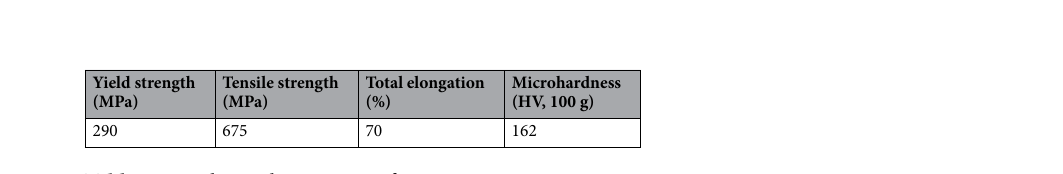
Table 2. Mechanical properties of